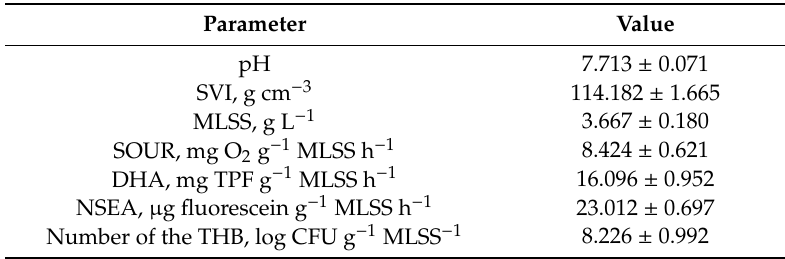
Table 1. Characteristics of the activated sludge (AS) obtained from the Klimzowiec sewage plant.